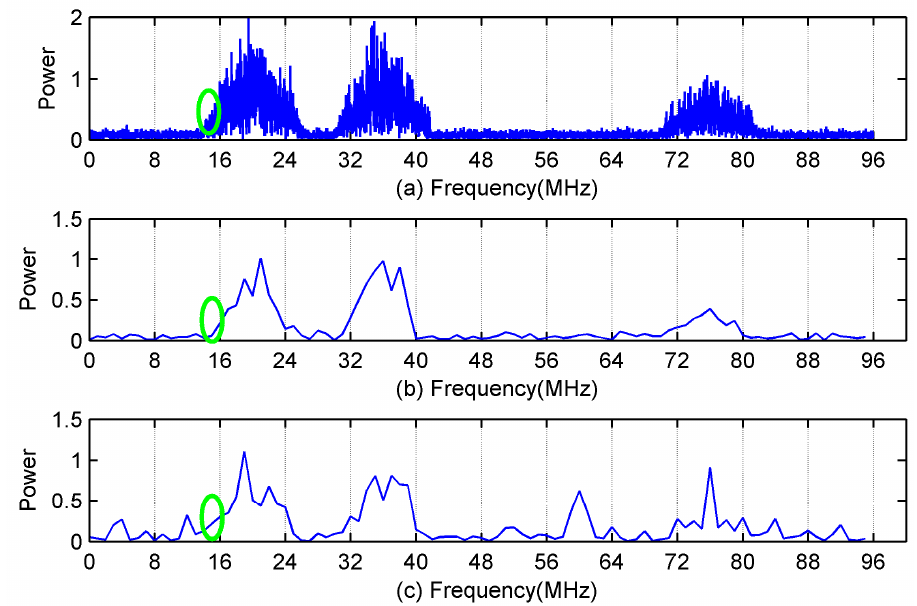
Figure 5. ( a ) Original power spectrum. ( b ) Estimated power spectrum at partial frequency bins using the proposed serial MCS. ( c ) Estimated power spectrum at partial frequency bins using the traditional parallel MCS. The green circle represents the Doppler shift caused by the multipath effect.